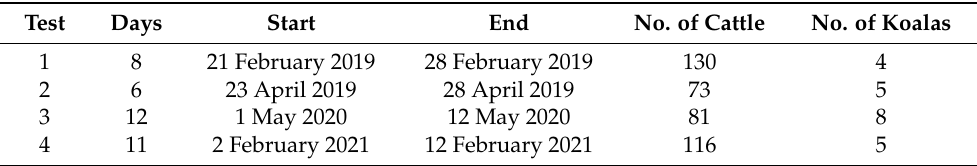
Table 1. The dates, number of days and the number of cattle and koalas studied in the four koala reaction